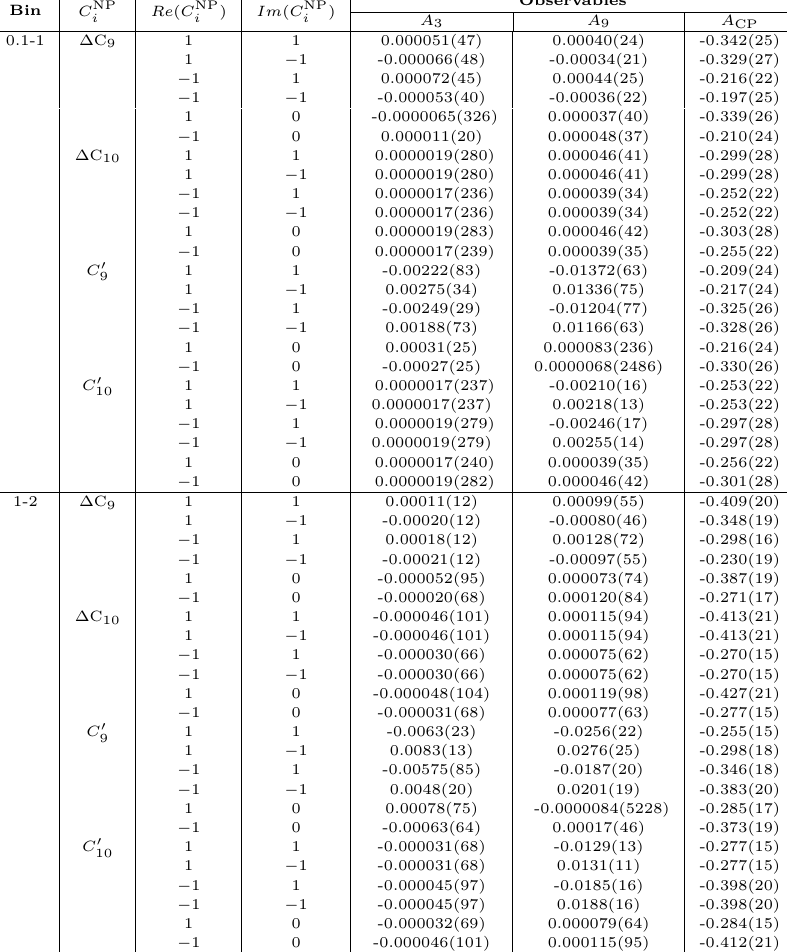
and C 0 for the q 2 bins 0 . 1 − 1 and 1 − 2 GeV 2 for a 9 , 10 9 , 10